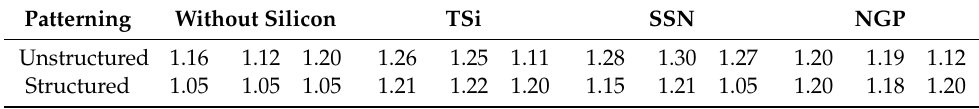
Table A2. Cell balancing factor of each pouch cell.